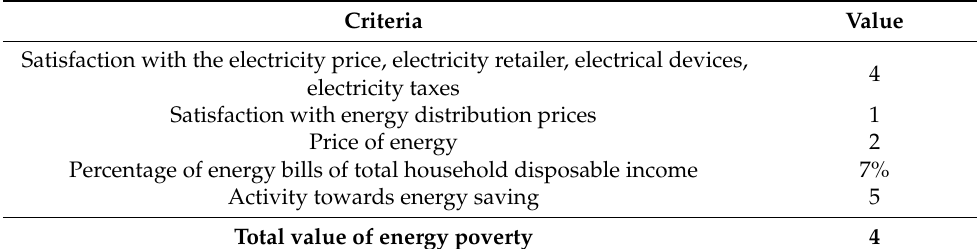
Table 5. The evaluated criteria for energy poverty. Criteria Value Satisfaction with the electricity price, electricity retailer, electrical devices, 4 electricity taxes Satisfaction with energy distribution prices 1 Price of energy 2 Percentage of energy bills of total household disposable income 7% Activity towards energy saving 5 Total value of energy poverty